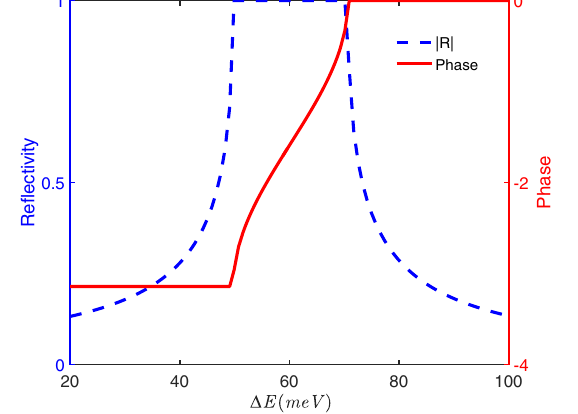
FIG. 2. The electron density distribution function in phase space of one slice.